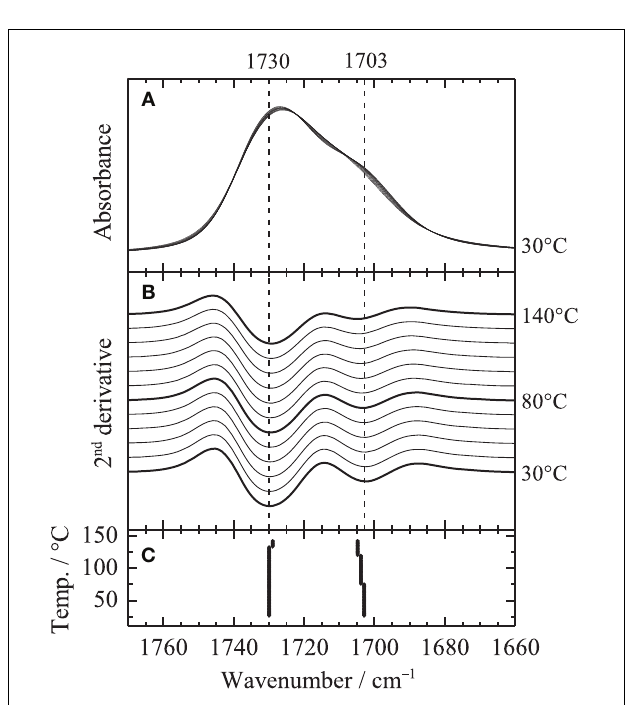
FIGURE 5 | (A) Close up of Figure 1 in the C = O stretching region, (B) second derivative spectra and (C) peak position of the second derivative spectra.